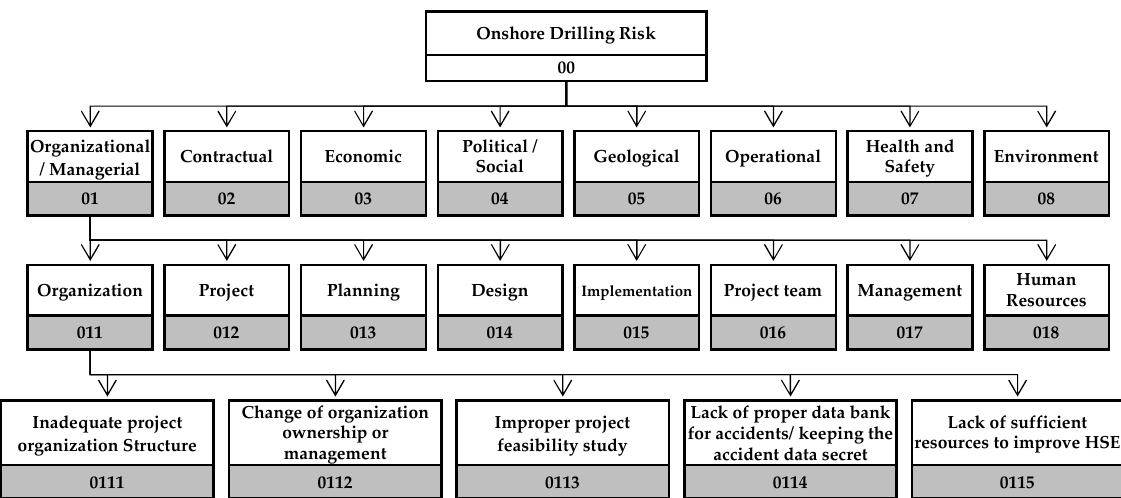
Figure 3. Hierarchical view of the proposed risk breakdown structure (RBS) for drilling projects (level 0, 1, 2, and 3 of branch 01).